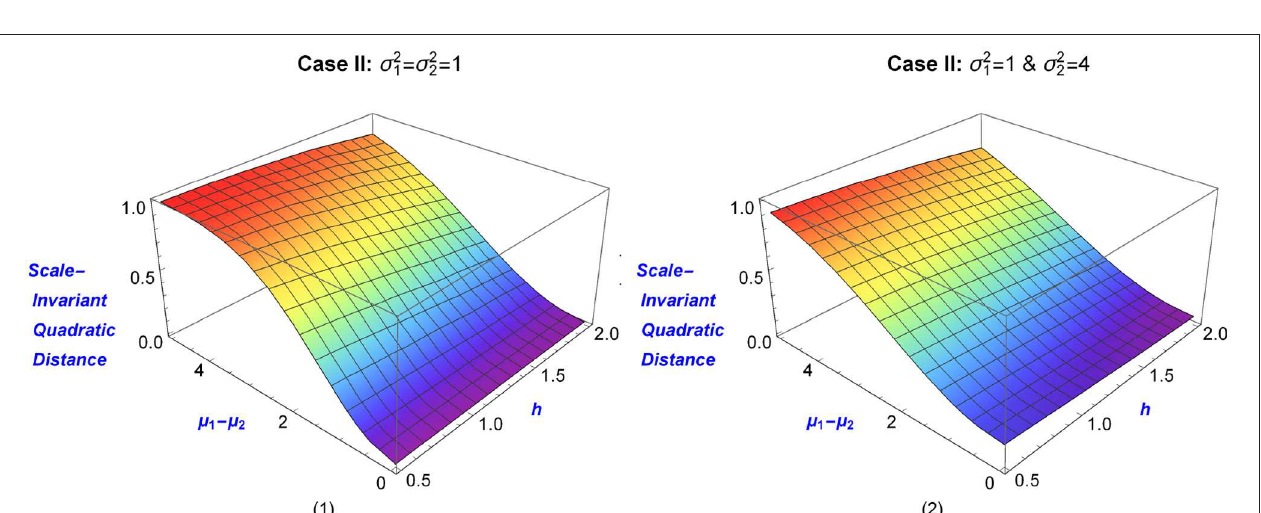
FIGURE 1 | Quadratic Distances of two univariate normal distributions, as a function of the tuning parameter h and the mean difference µ 1 distance between N ( µ 1 ,1) & N ( µ 2 ,1), while Graph (2) shows the distance between N ( µ 1 ,1) & N ( µ 2 ,4). Blue color corresponds to small distances (as measured by the µ 2 ), with the change of color indicating a larger difference in means. magnitude of µ 1 −